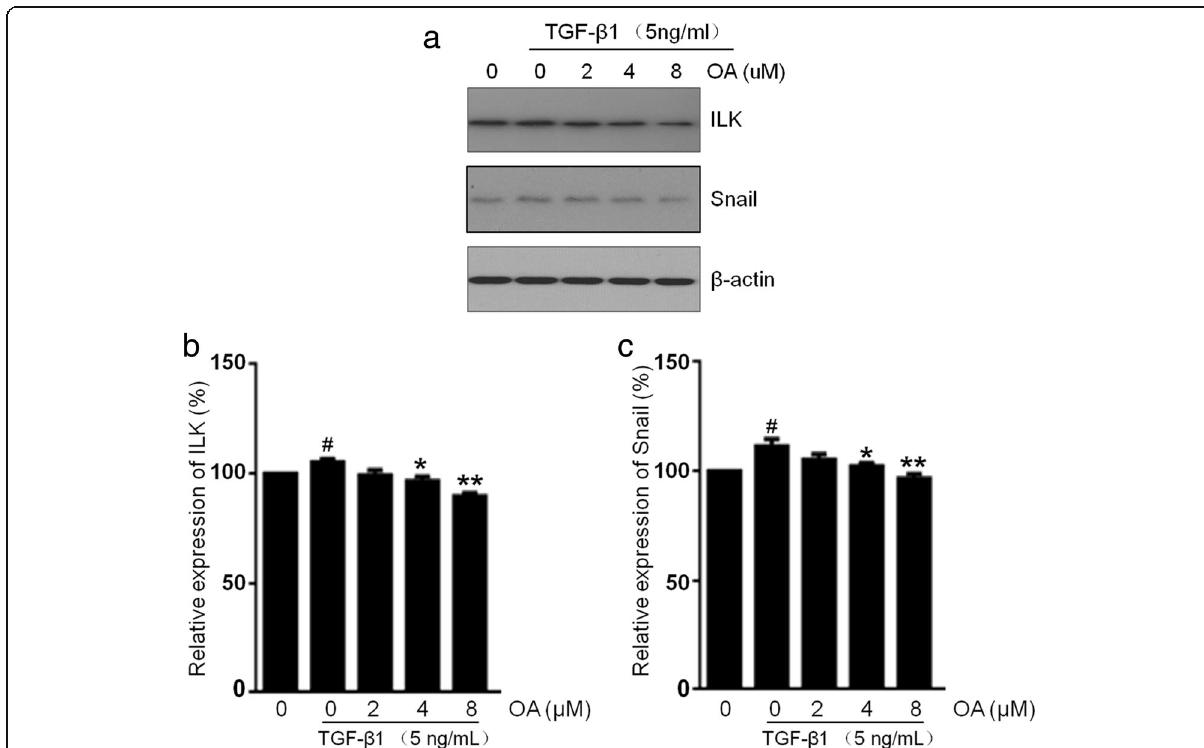
Fig. 6 Effects of OA on the ILK and Snail expression in NRK-52E cells. The cells were incubated with 5 ng/mL of TGF- β 1 for 48 h with different concentrations of OA (0, 2, 4, 8 μ M). a The expression level of ILK and Snail was determined by Western blotting. b , c The expression level was quantitatively analyzed with Image J software. The data showing mean ± SD. # P < 0.05 vs. 0 ng/mL TGF- β 1. * P < 0.05, and ** P < 0.01 vs. 0 μ M OA in the presence of 5 ng/mL TGF- β